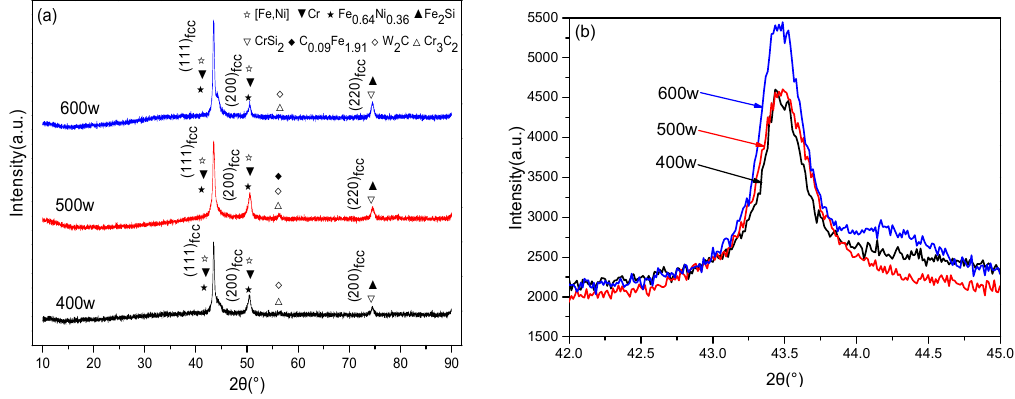
Figure 3. ( a ) XRD pattern of the remelted layer at 400 W, 500 W, and 600 W, and ( b ) first primary peak.